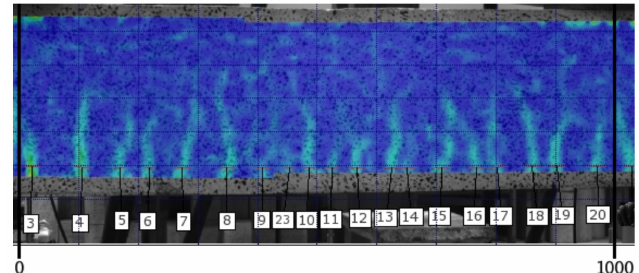
Figure 21. Strain map of the middle section of beam A2M-2 at the load level of 0.75.